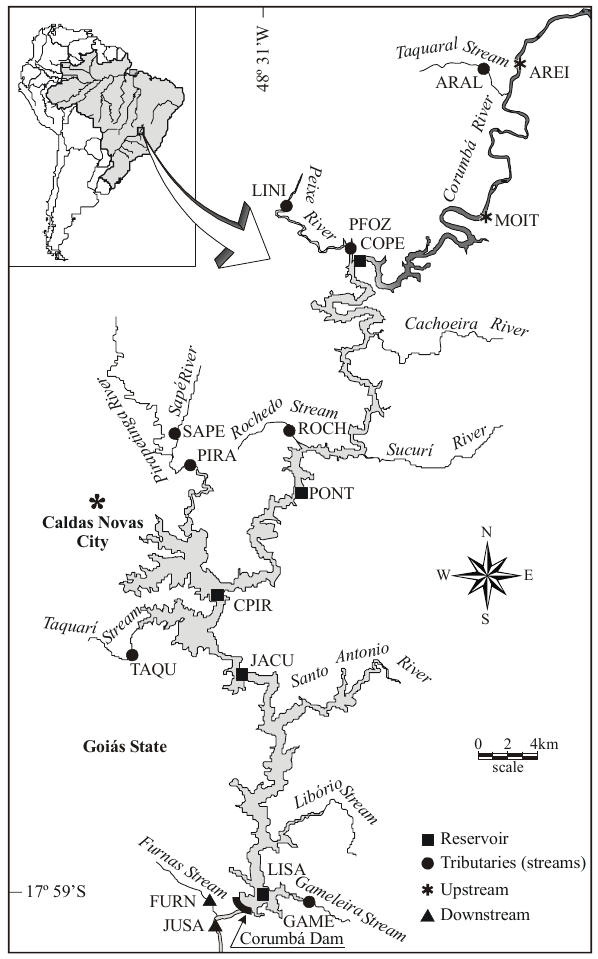
Fig. 1 . Studied area. Map of the Corumbá river, where the Corumbá reservoir was formed, showing the sampling